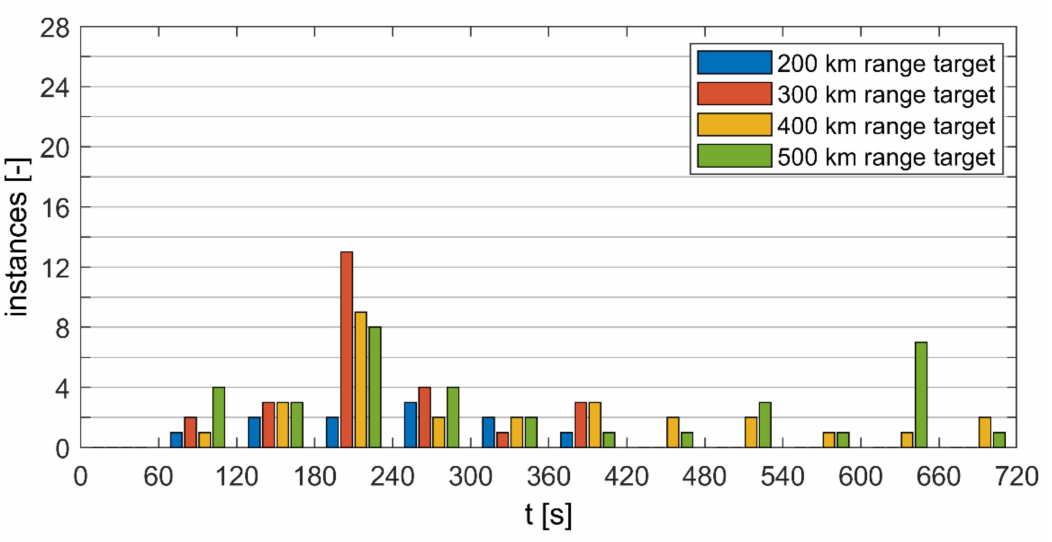
Figure 10. REX engagement instances binned by engagement time for WLTC 3b and vehicle mass of 1500 kg.